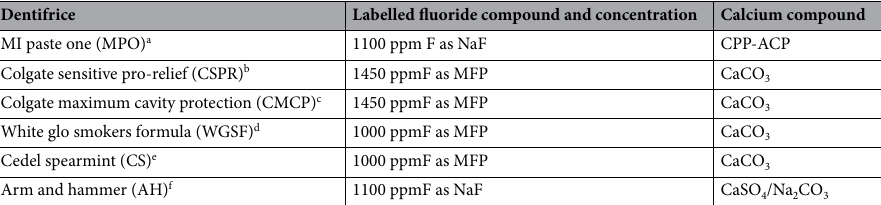
Table 1. Fluoride type and added amount in calcium-containing dentifrices tested. a Ingredient list: pure water, glycerol, RECALDENT (CPP-ACP) casein phosphopeptide-amorphous calcium phosphate, sorbitol, CMC-Na, propylene glycol, silicon dioxide, titanium dioxide, xylitol, phosphoric acid, flavoring, methyl salicylate, sodium saccharin, Ethyl p-hydroxybenzoate, propyl p-hydroxybenzoate, butyl p-hydroxybenzoate, sodium-N-lauroyl sarcosinate. b Ingredient list: calcium carbonate, water, sorbitol, arginine, bicarbonate, sodium lauryl sulphate, flavour, sodium monofluorophosphate, sodium silicate, carmellose sodium, sodium bicarbonate, titanium dioxide, acesulfame potassium, xanthan gum, sucralose, limonene. c Ingredient list: calcium carbonate, water, glycerin, arginine, sodium lauryl sulphate, sodium monofluorophosphate, cellulose gum, flavour, sodium bicarbonate, benzyl alcohol, tetrasodium pyrophosphate, sodium saccharin, sodium hydroxide, CI 77891. d Ingredient list: calcium carbonate, aqua (water), glycerin, sorbitol, silica, aroma (flavour), solum diatomeae (diatomaceous earth), sodium lauryl sulphate, carboxymethyl hydroxyethylcellulose, chondrus crispus (carrageenan), CI 77891 (titanium dioxide), sodium saccharin, rosa canina fruit oil, sodium monofluorophosphate. e Ingredient list: water, calcium carbonate, glycerin, aluminium hydroxide, silica, sodium lauryl sulfate, cellulose gum, sodium monofluorophosphate, sodium saccharin, methylparaben, flavours, mineral oil, PEG-60 hydrogenated castor oil, BHA. f Ingredient list: Sodium bicarbonate (baking soda), glycerin, PEG-8, hydrated silica, PEG/PPG-116/66 copolymer, calcium sulphate, sodium lauryl sulfate, aroma, dipotassium phosphate, sodium carbonate, sodium saccharin, cellulose gum, sodium fluoride, limonene, CI